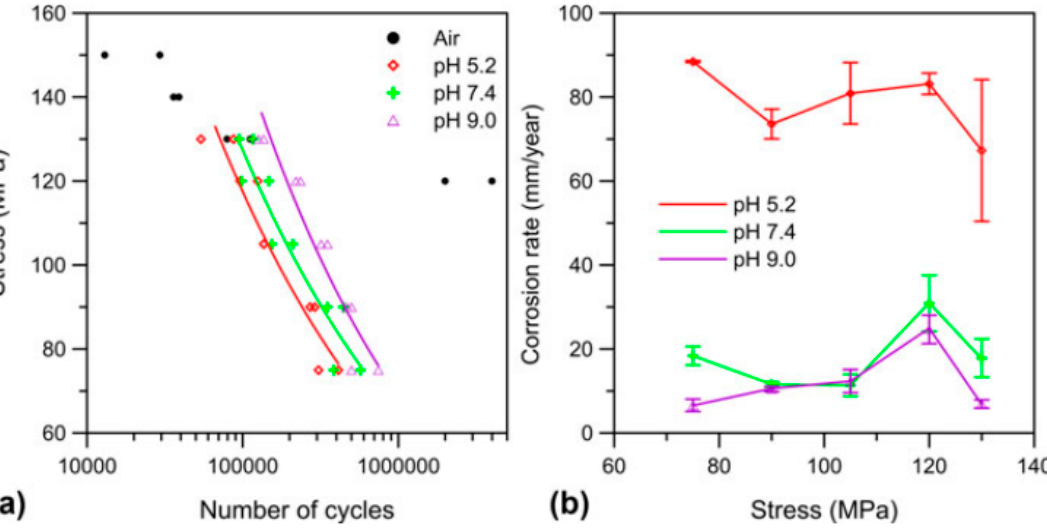
Figure 4. Effect of pH value on the material properties of AM60 magnesium alloy in Phosphate Buffered Saline (PBS) solutions, including ( a ) HCF region of S-N curve, and ( b ) corrosion rate [47]. Table 3. Mechanical properties of AM50 magnesium alloy